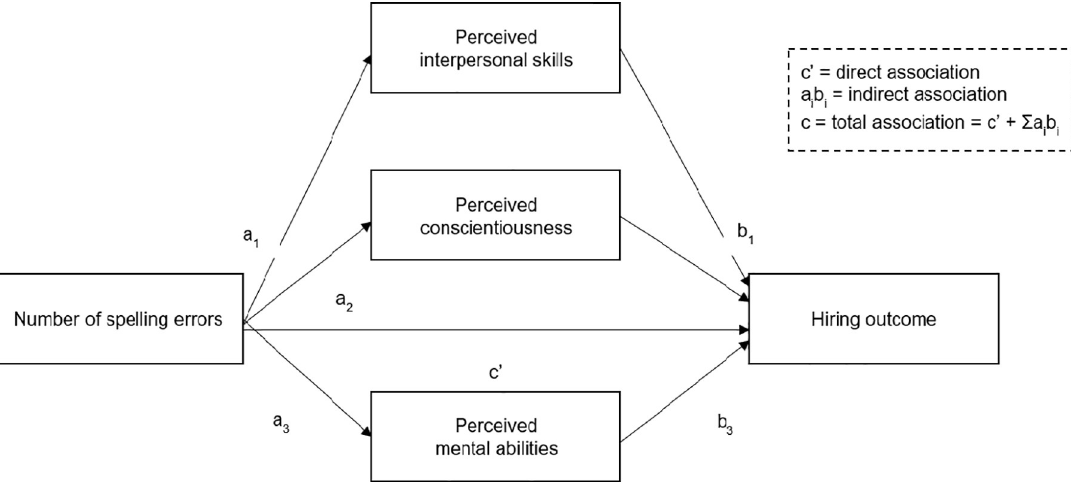
Fig 1. Core mediation framework outlined in Subsection